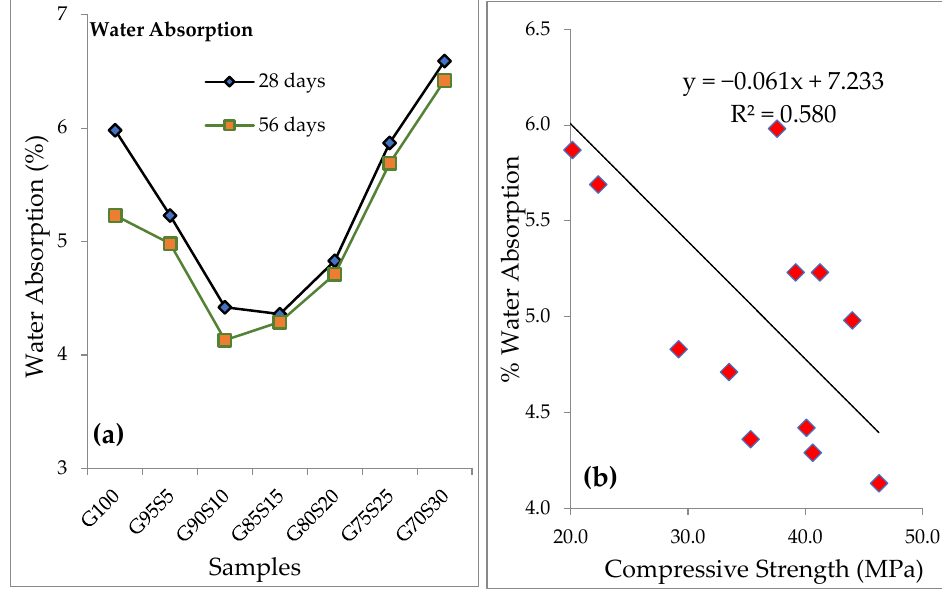
Figure 6. ( a ) WA test results; ( b ) correlation of compressive strength with WA values.